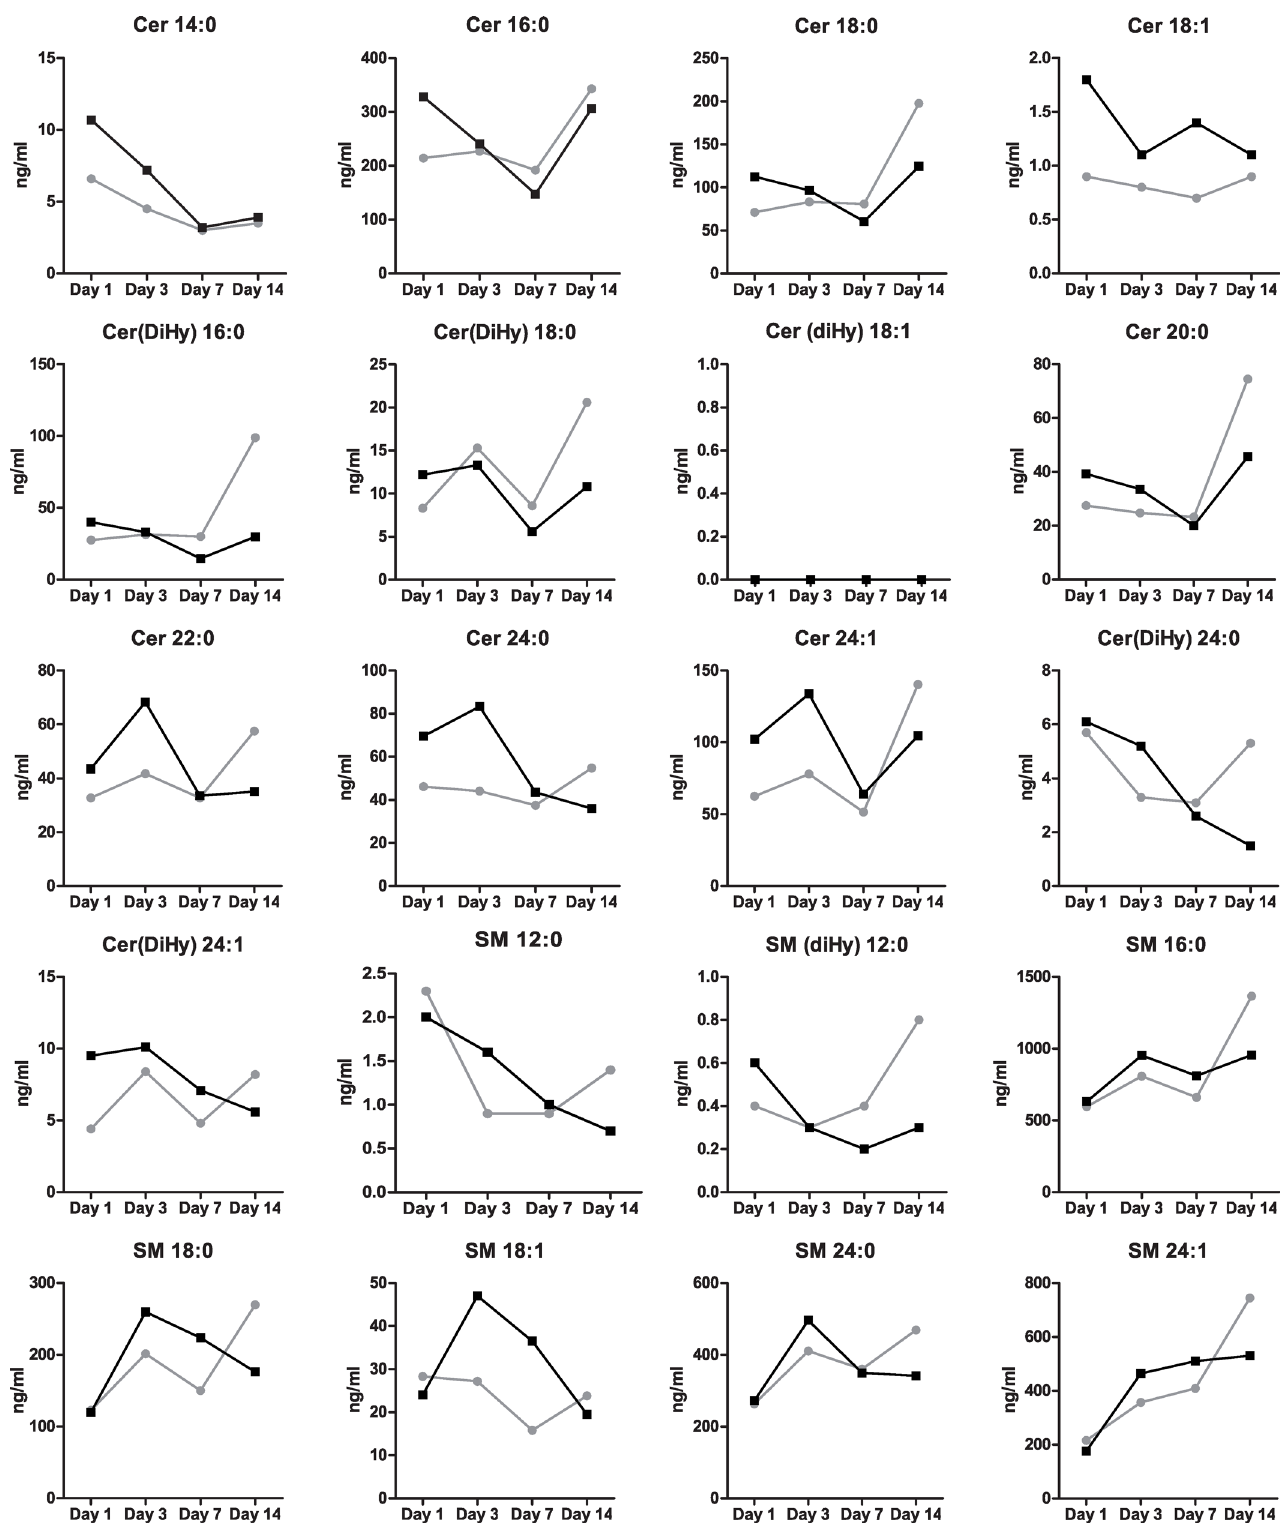
Fig 1. Median values of sphingolipids over time. Grey: No CLD or alive. Black: CLD or died.